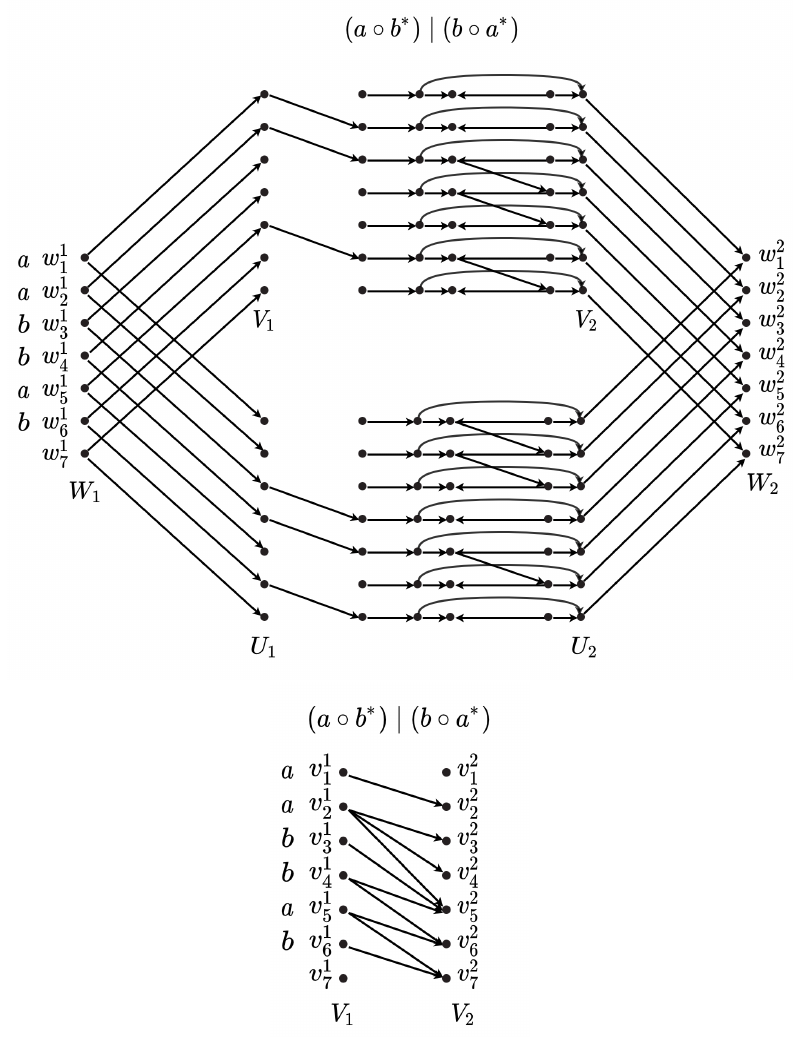
Figure 3. Solution graphs for the text T = aabbab . ( Top ): the solution graph for ( a ◦ b ∗ ) | ( b ◦ a ∗ ) . ( Bottom ): an equivalent, simpler solution graph for ( a ◦ b ∗ ) | ( b ◦ a ∗ )